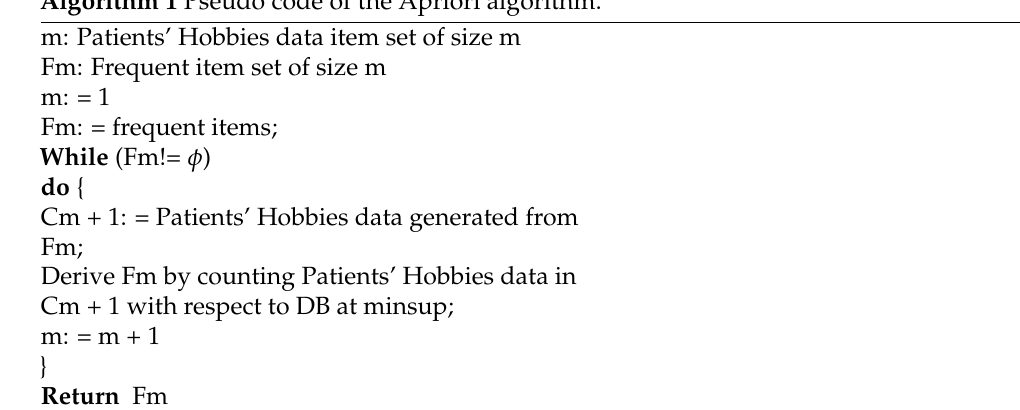
Algorithm 1 Pseudo code of the Apriori